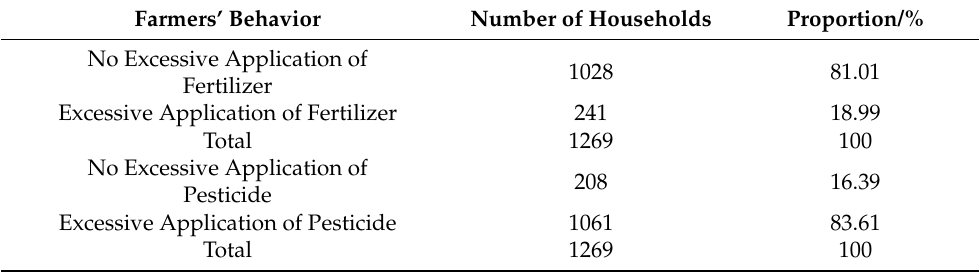
Table 5. Statistics of Overuse of Fertilizer and Pesticide among Sample